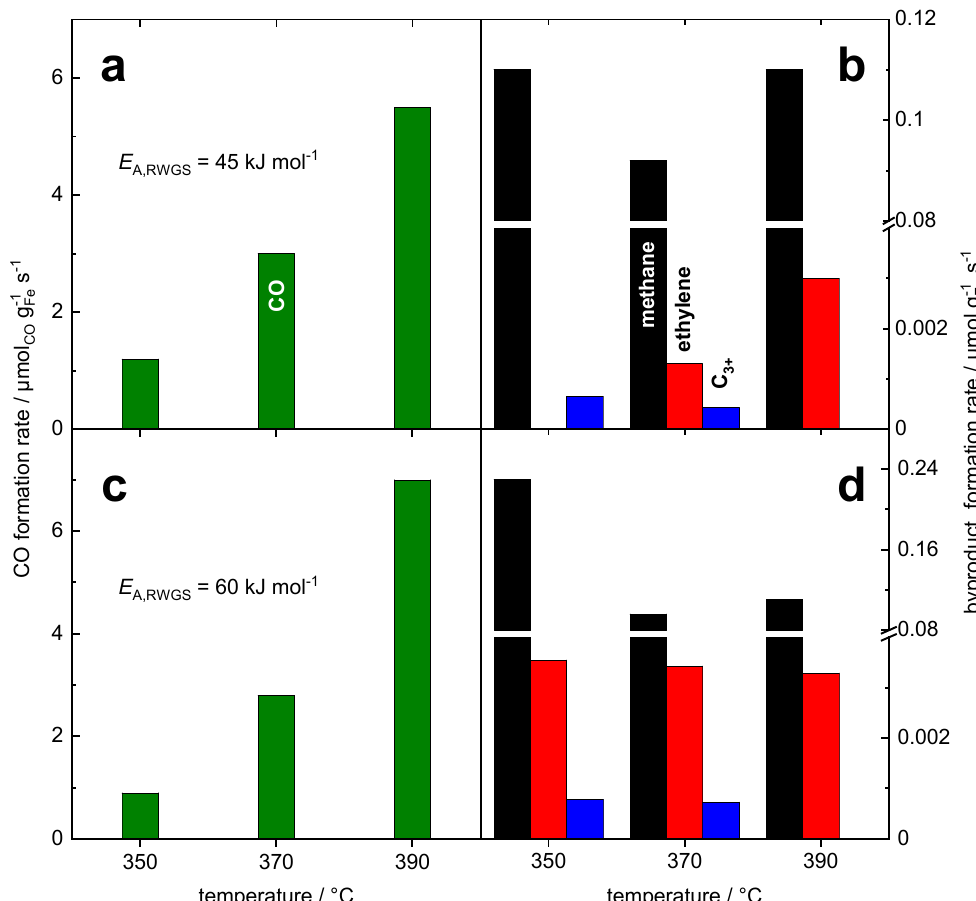
Figure 6. Product formation after 12 h for CO 2 hydrogenation at temperatures between 350 and 390 °C with two different core-shell materials: 13Fe(8)@SiO 2 ( a and b ), 15Fe(4)@SiO 2 ( c and d ); left ( a and c ): formation rate of CO via RWGS reaction, right ( b and d ): formation rate of methane and C 2+ compounds, conditions: H 2 /CO 2 = 4.5, p = 1 bar, (cid:1848)(cid:4662) (cid:2930)(cid:2925)(cid:2930)(cid:2911)(cid:2922) = 100 mL STP /min.